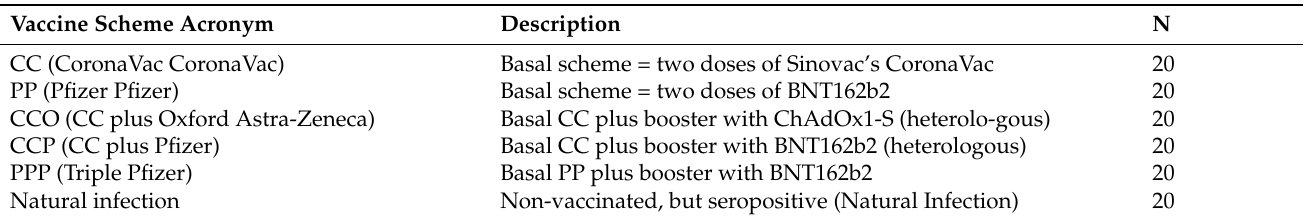
Table 1. Vaccination schemes and sample distribution, Chile